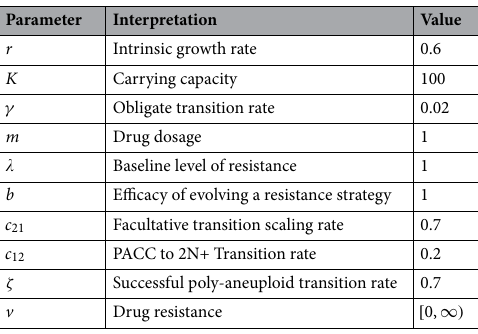
Table 1. PACC parameter definitions and values used in